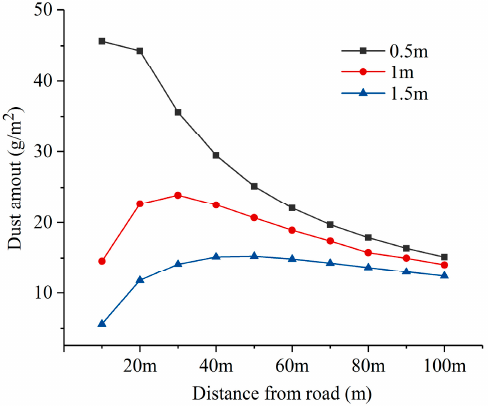
Figure 5. Changes of dustfall at different heights from the ground.